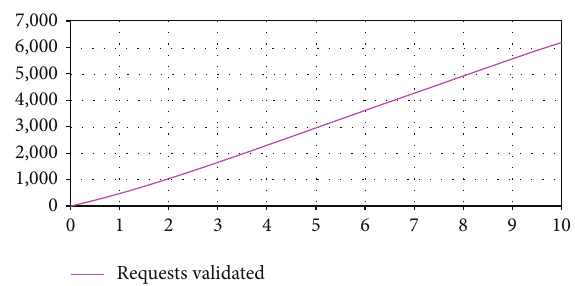
Figure 2: Pattern of behavior for the input parameter Requests Received Rate (E1).